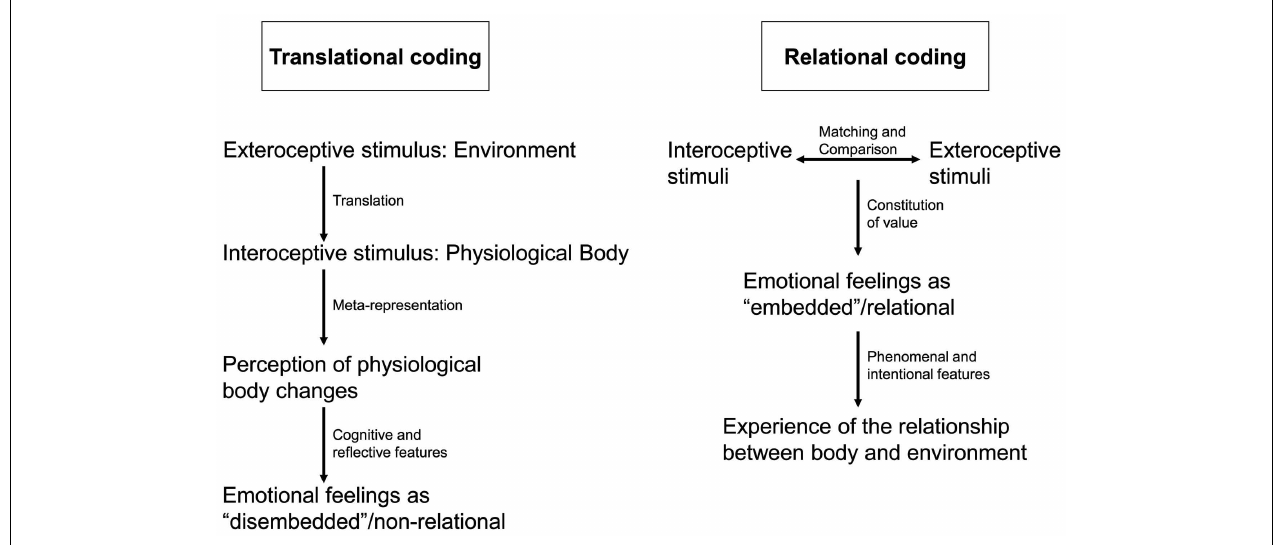
James–Lange theory leads to emotional feelings.This is different in relational coding on the right side. Here intero- and exteroceptive stimuli are coded in relation to each other with this relation resulting in emotional feeling and subsequent experience of the relationship between body and